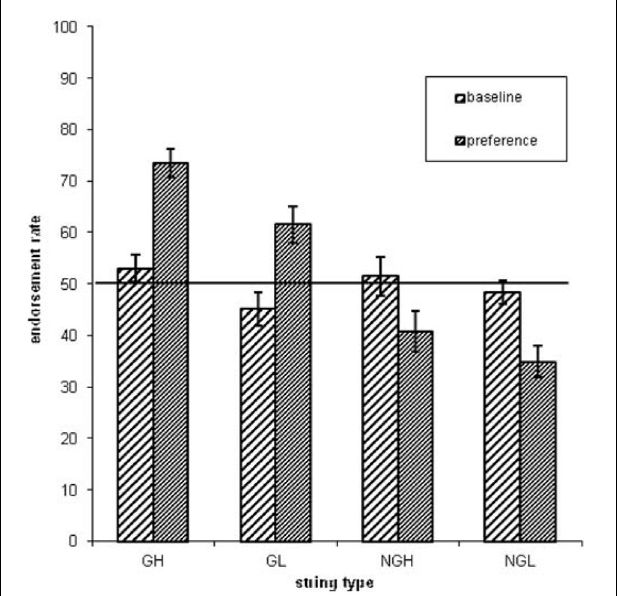
FIGURE 2 | The endorsement rates as a function of grammaticality status (G = grammatical sequences, NG = non-grammatical sequences) and associative chunk strength (H = high ACS sequences, L = low ACS sequences). Error bars correspond to standard error of the